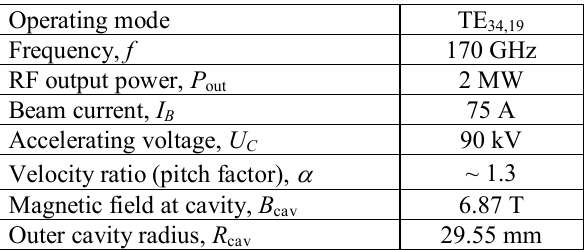
Table 1. Design Parameters for the Coaxial-Cavity Gyrotron